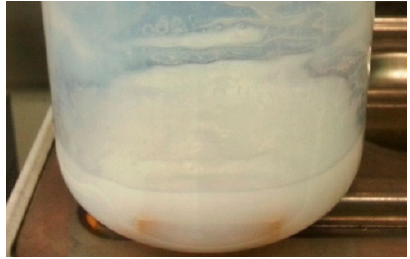
Figure 6. Monolith dipped in the washcoat.